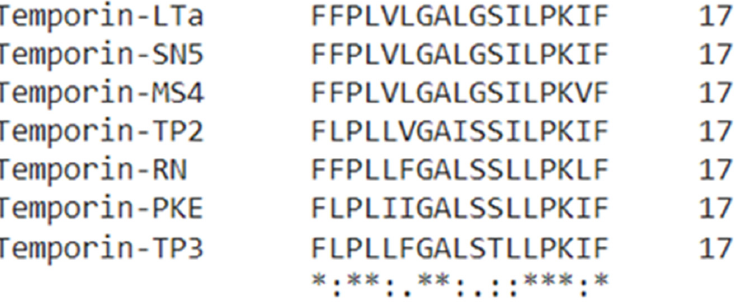
Figure 3. The multiple sequence alignments between the novel peptide and several peptides in the temporin family with the same sequence length by Clustal Omega. An * (asterisk) indicates that the residue in this position in these sequences is fully conserved. A: (colon) indicates conservation between amino acids with strongly similar properties. A. (period) marks conservation between residues of weakly similar properties. The numbers at the ends of the sequences are the numbers of the amino